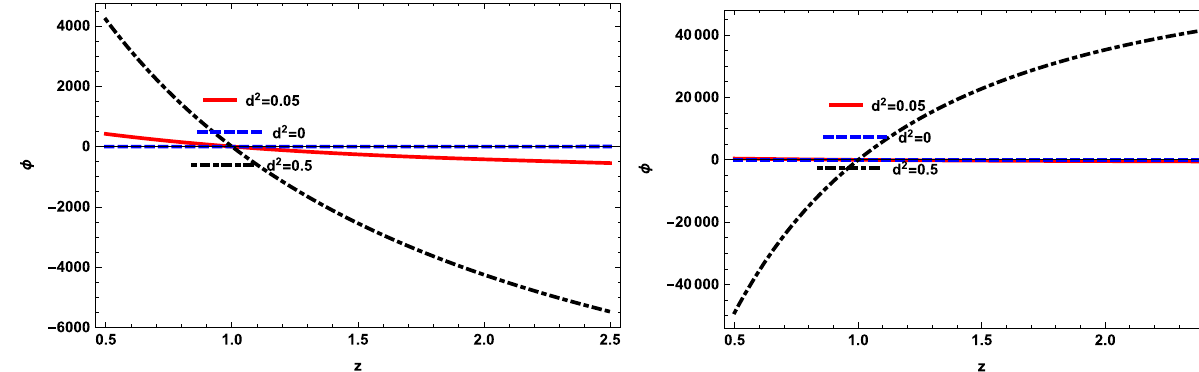
Fig. 22 Plot of φ verses z for u = 1 and u = 2 . 002 for tachyon scalar field model